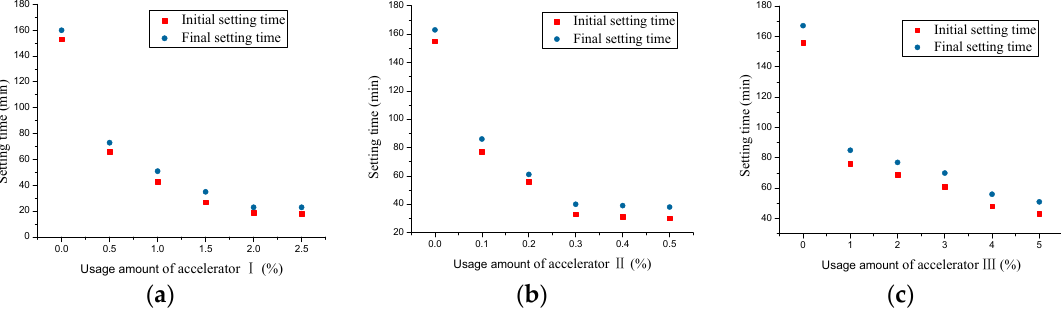
Figure 3. Setting time of grouting materials under different usage amounts: ( a ) accelerator I; ( b ) accelerator II; and, ( c ) accelerator III.